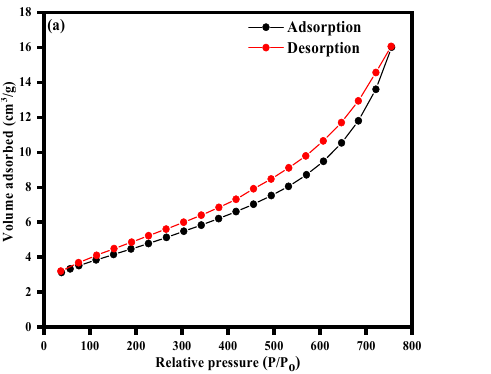
images after the accumulation of spherical or nearly spherical LP-ZnO NPs in a rod-like pattern. The N 2 adsorption/desorption isotherm analysis was further validated for the pore size distribution using DFT analysis. Our results ascertained amorphous/crystalline heterostructure with slit-like microporous structures of higher specific surface area. Mean- while, BET surface area of 24.543 m 2 /g with a volume of 0.037 cc/g and half pore width (Mode) of 13.845 Å was attained, as depicted in Figure 8b. half pore width (Mode) of 13.845 Å was attained, as depicted in Figure 8b.